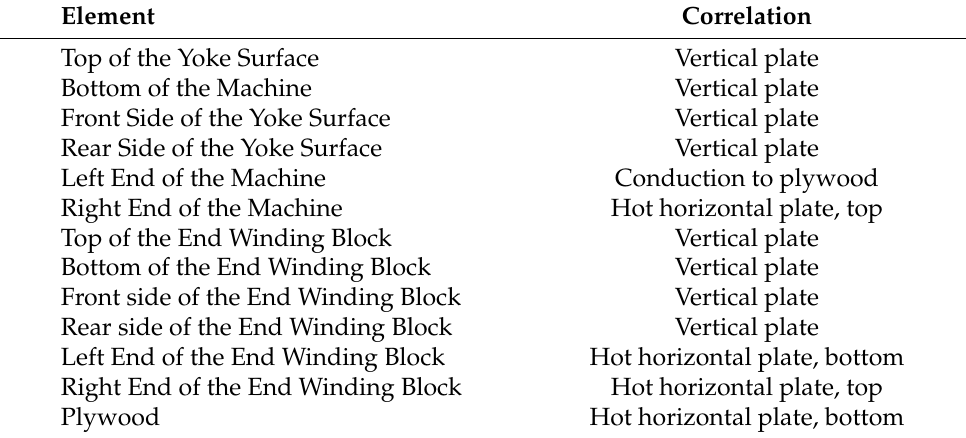
Table 5. Correlations for the vertical